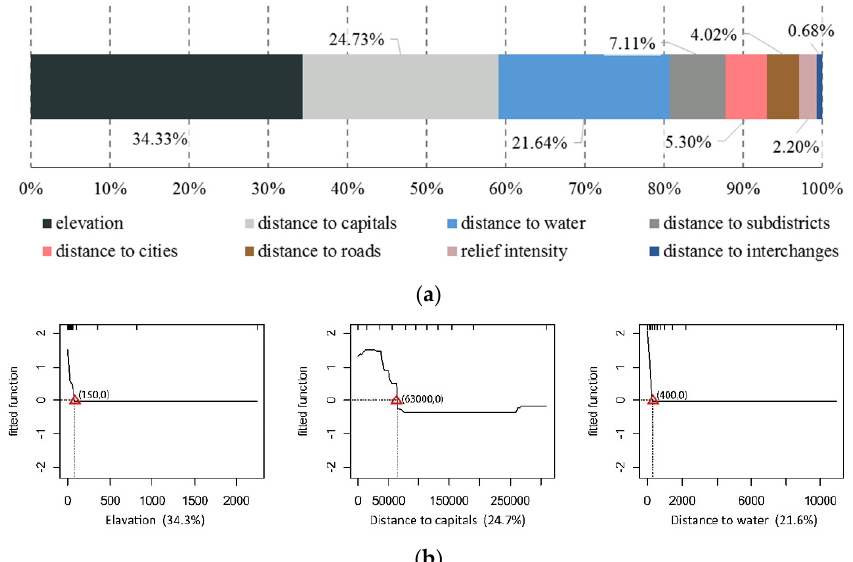
Figure 15. Factor contribution ranking and marginal effect of LS–ES. ( a ) Contribution degree of factors; ( b ) marginal effect of factor with a contribution degree over 10%.